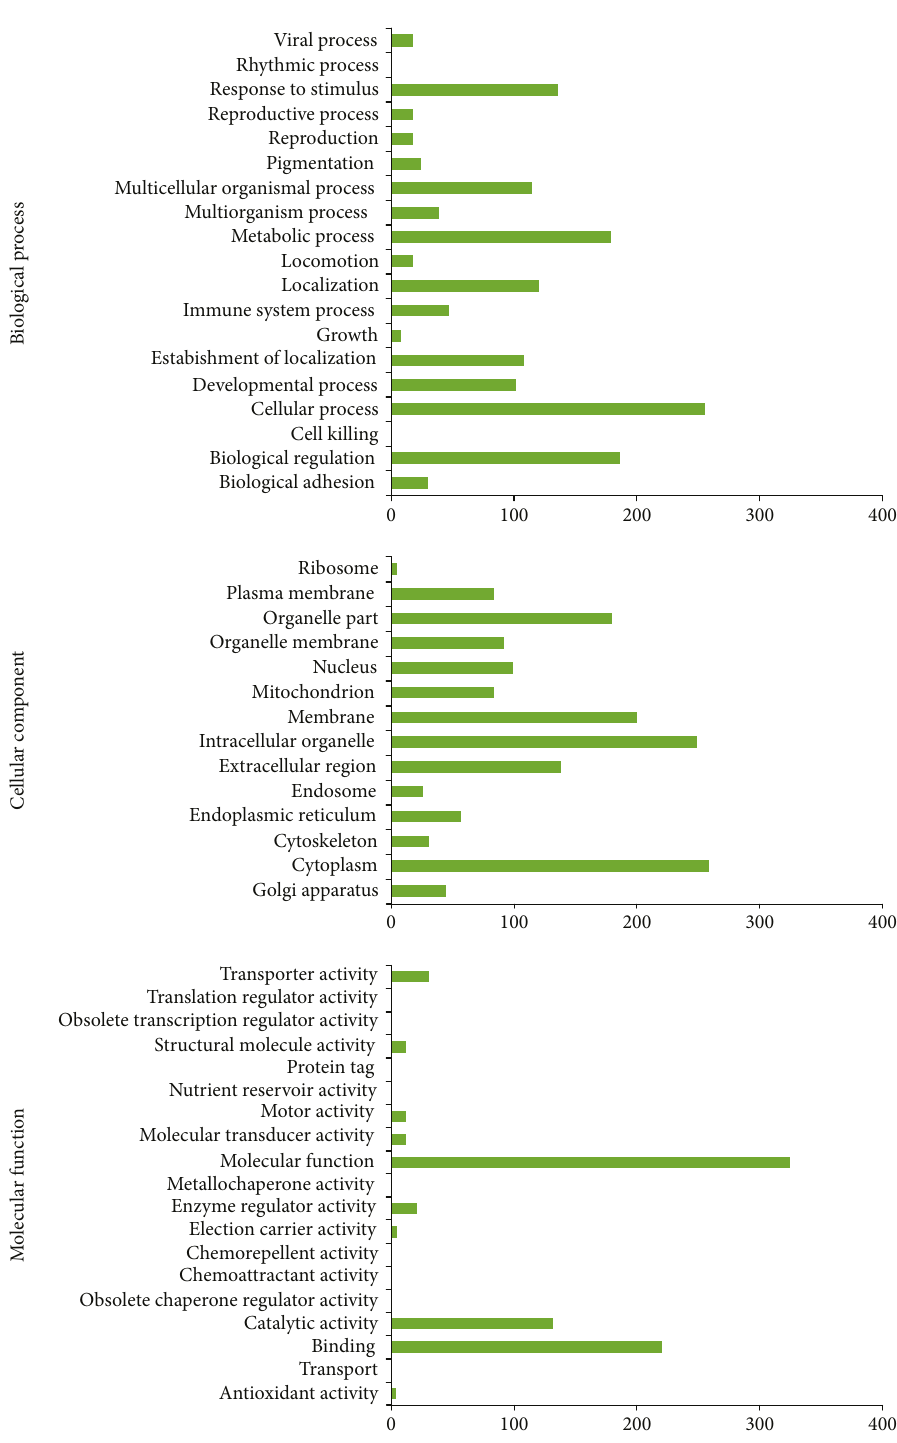
Figure 3: The biological processes, cellular components, and molecular function of the mouse primary cultured cell (P0) proteins (as determined by GO). The PCA of proteome dynamics based on the protein information generated by high-resolution mass spectrometry. The ordinate indicates the biological function, cellular component, and molecular function of the protein. The abscissa indicates the number of identi fi ed proteins. The names of the proteins classi fi ed in Table 3 are listed by their detailed molecular Hprt1, Rplp1, Ppia, Rps18, Pgk1, Tfrc, Ywhaz, and Gapdh; with a scatter plot ( y -axis =P3, x -axis =P0). The average Supplementary Figure 1). The quantitative values of Tubb5, quantitative value of P3-expressed proteins decreased to Flnb, Tln1, Col1a1, Iqgap1, Hspa5, Flnc, Thbs1, Fn1, 69.4% compared to P0-expressed proteins (Atp5f1, B2m,